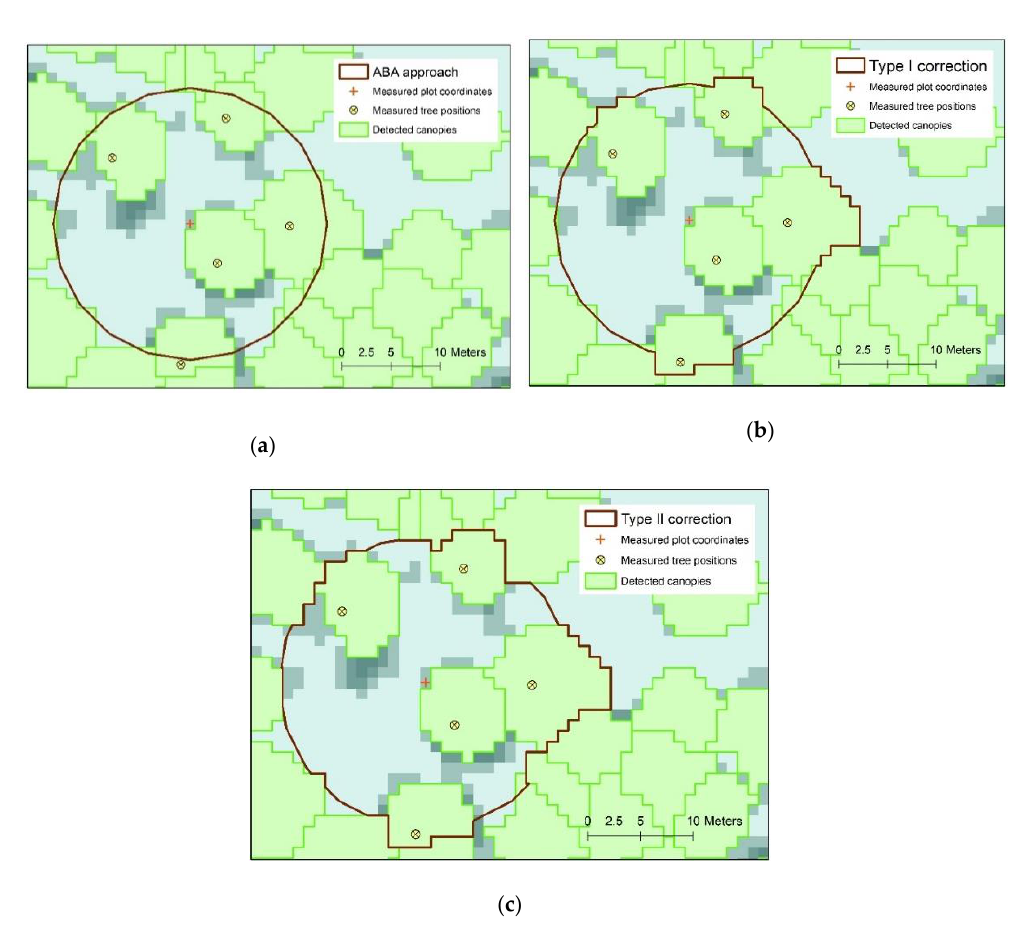
Figure 3. ( a ) Traditional area-based approach (ABA), in which the sample edge is based on a fixed plot radius value; ( b ) the edge of the sample plot turns into an irregular edge that follows the presence of the canopies of the detected and measured trees (Type I correction); ( c ) the irregular edge of the sample plots is adjusted again (Type II correction) to remove the canopies whose center point is located outside of the measuring range (plot radius).